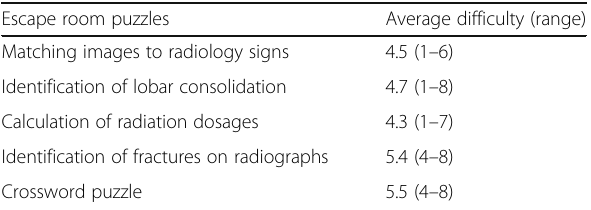
Table 2 Participant feedback on difficulty level of the escape room puzzles, scored on a scale of 1 to 10, where 1 = too easy; 5 = about right level; 10 = too